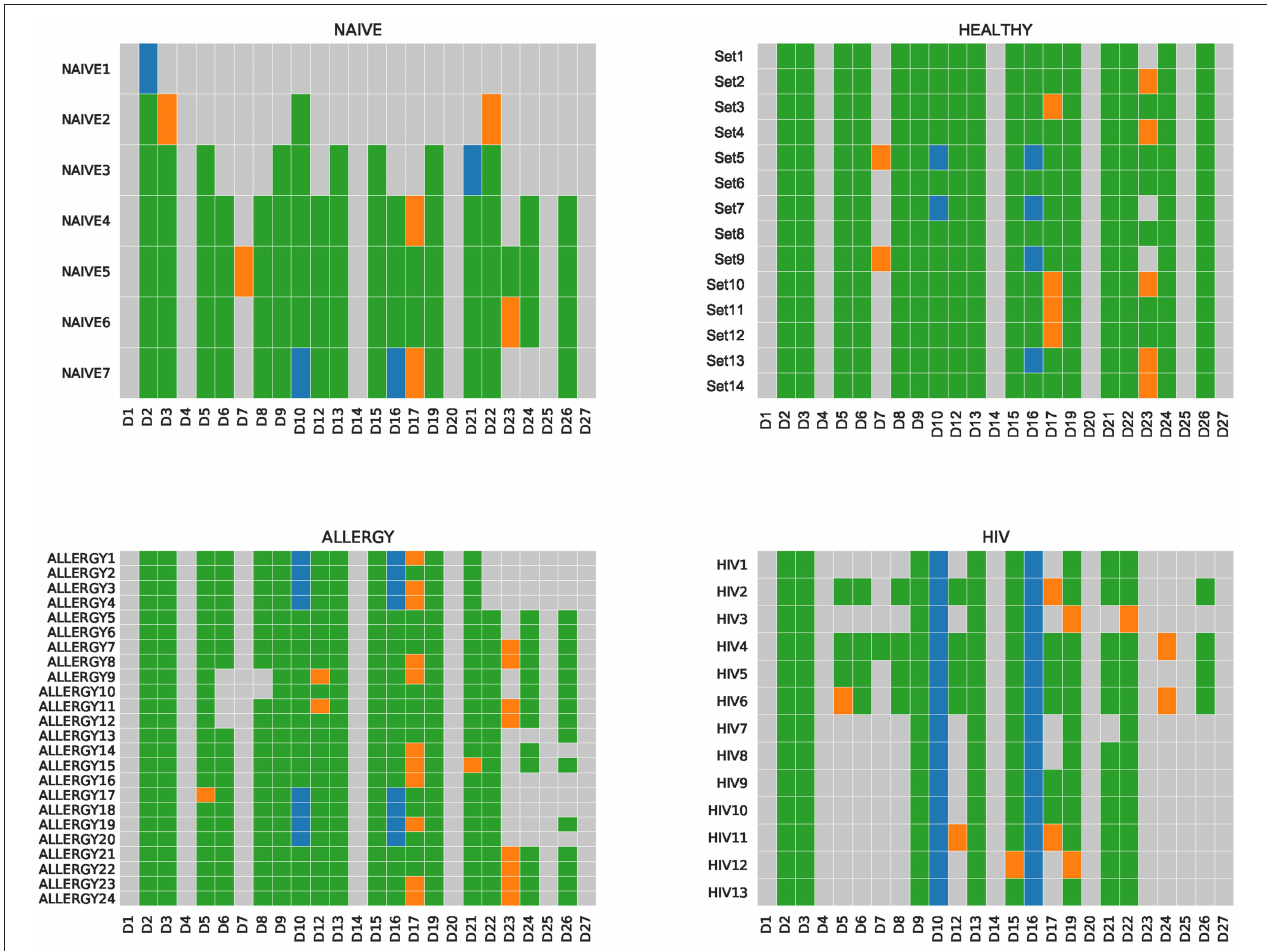
FIGURE 4 | De novo reconstructions of D genes across NAÏVE, HEALTHY, ALLERGY, and HIV datasets. Human D genes that were reconstructed (missed) are shown by colored (gray) cells. Green and orange cells correspond to reconstructed D genes listed in the IMGT database. Green cells correspond to substrings of known D genes. Orange cells correspond to substrings that differ from substrings of known D genes by the first or the last nucleotide. Blue cells correspond to novel variants of D10 (IGHD3-10) and D16 (IGHD3-16) genes. For the Set5, Set7, ALLERGY1–ALLERGY4, ALLERGY17–ALLERGY20, HIV1–HIV13, IgScout inferred two variants (novel and known) of D10 (IGHD3-10). The NAIVE datasets are listed in the increasing order of the number of consensus CDR3s in